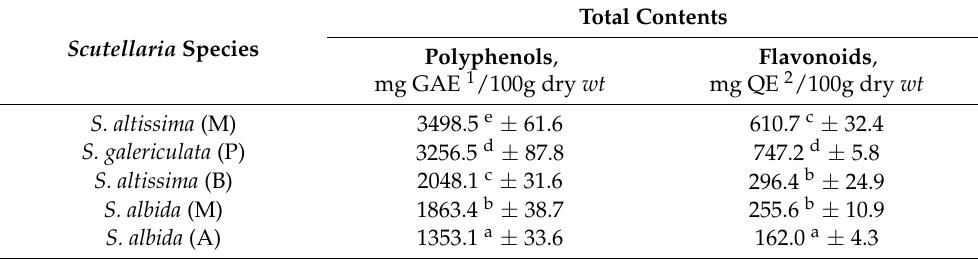
Table 1. Content of Phenolic and Flavonoid Compounds in Scutellaria Species.